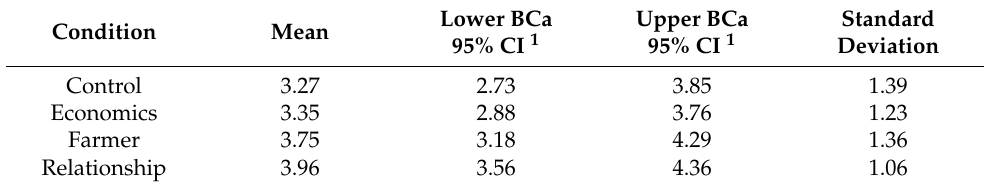
Figure 4. Mean likelihood of prescribing antibiotics by vignette condition ( n = 97); response units represent 5-point Likert scale from 1 ( very unlikely ) to 5 ( very likely ). Error bars represent 95% bias- corrected and accelerated bootstrap confidence intervals. Table 2. Mean Likelihood of Prescribing Antibiotics by Vignette Condition.